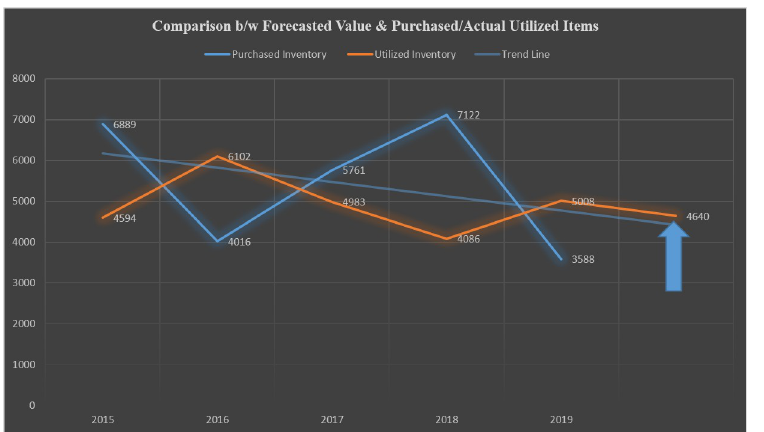
Fig 5. Comparison of forecasted value with purchased/actual utilized